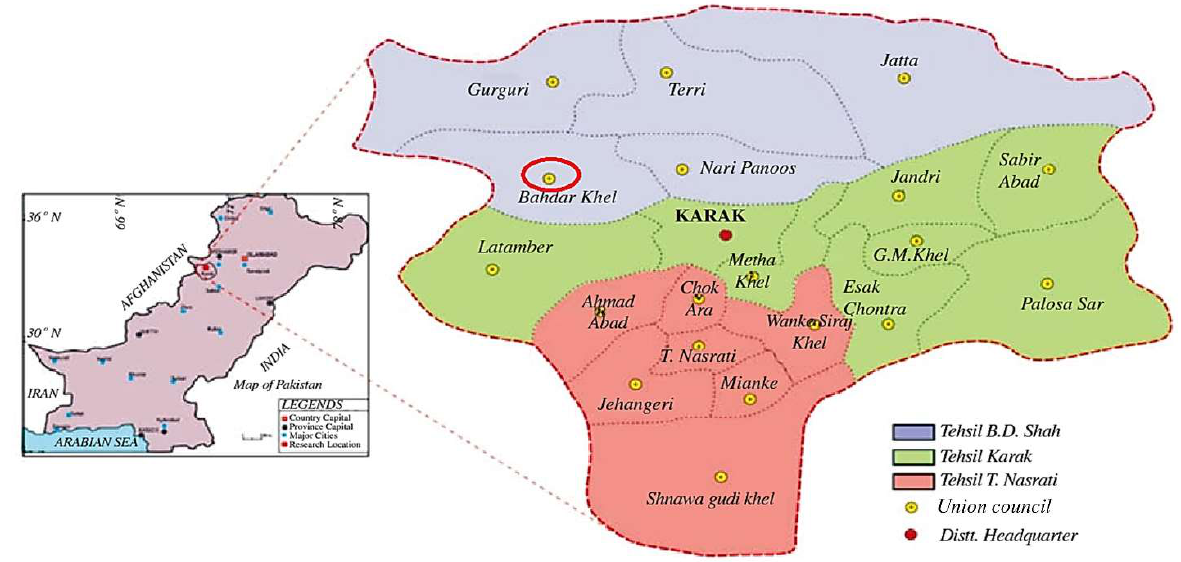
Figure 1. Map of Karak showing the location of Bahadur Khel Salt Mines (red circle).